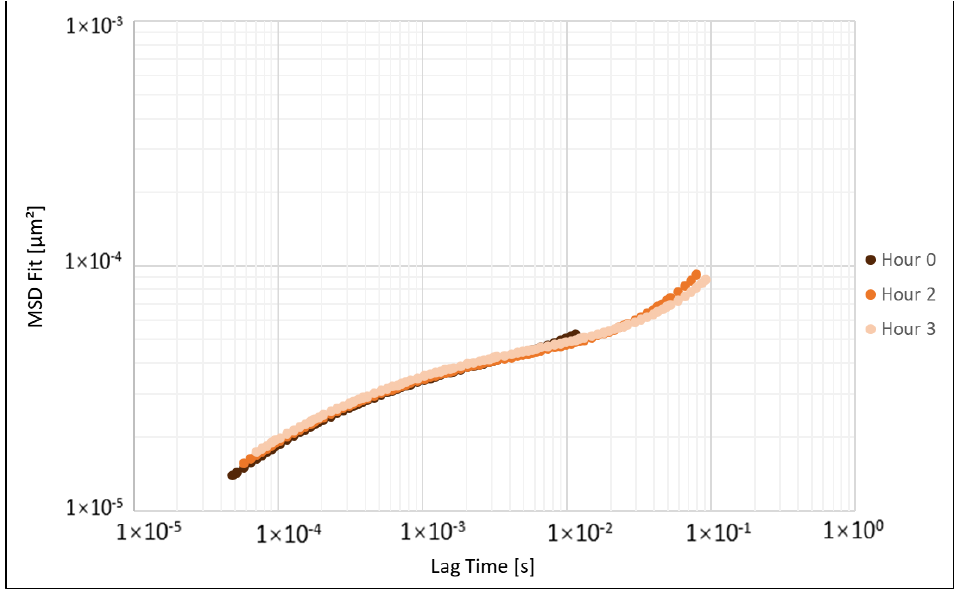
Figure 5. 4 wt % CAPB, 4 wt % SLES, 15 wt % jojoba oil emulsion variation in MSD values over a 3 ‐ h period.